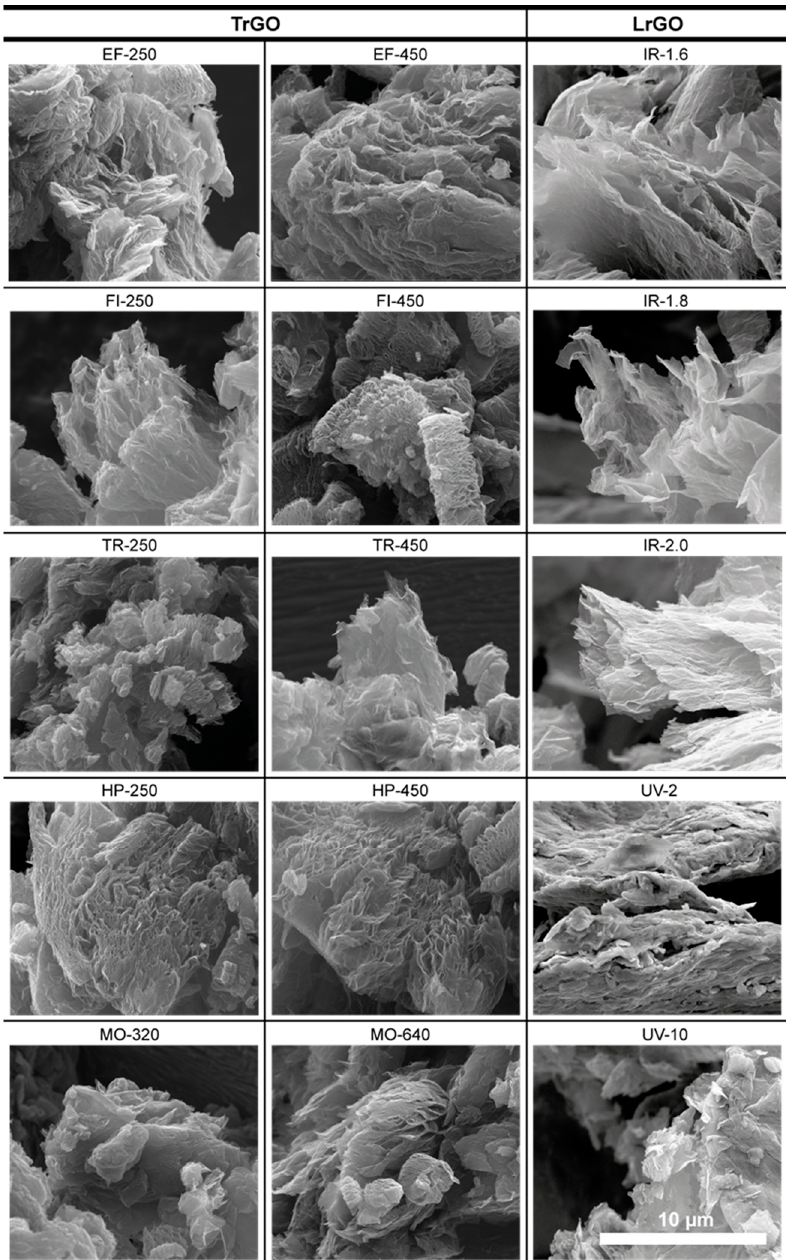
Figure 6. SEM images of TrGO and LrGO representative samples. Scale bar shown at bo tt om right applies to all